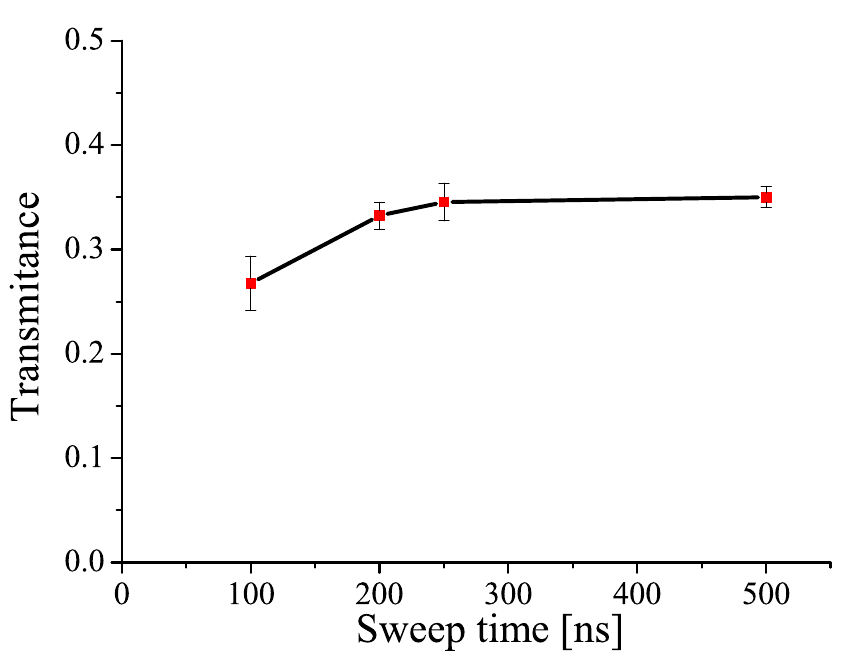
Figure 24. Transmittance of the passband for various sweep